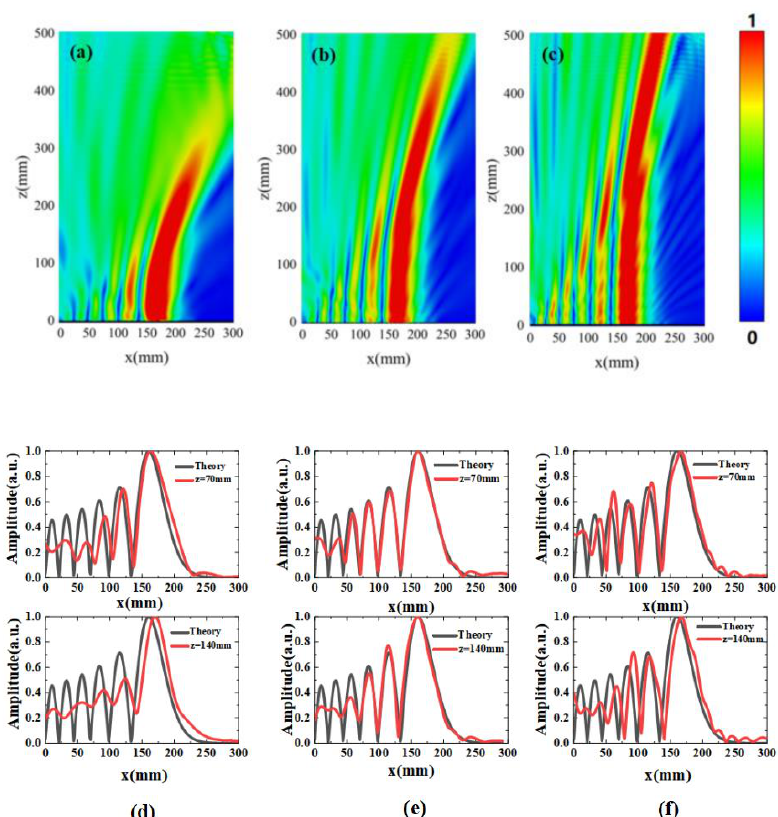
Figure 4. The simulated electric field distributions of the produced Airy beams with amplitude modulation are shown at ( a ) 10 GHz, ( b ) 15 GHz, and ( c ) 20 GHz. Additionally, the simulated amplitude distribution of the metasurfaces in reflection geometry on the xoz plane is presented at ( d ) 10 GHz, ( e ) 15 GHz, and ( f ) 20 GHz.